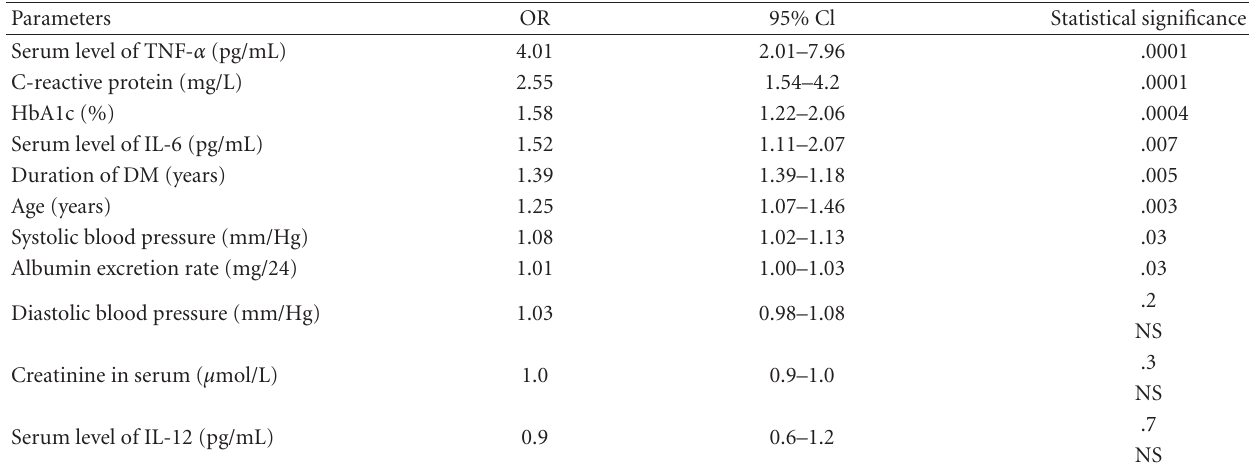
Table 3: Unadjusted retinopathy risk